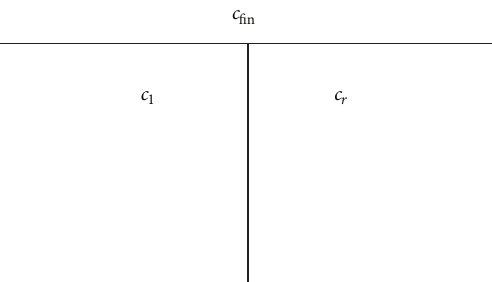
Figure 3: Spacetime diagram sketch of a spatial step-like disconti- nuity (acoustic black hole-like) followed by a temporal one leading to a final homogeneous configuration.